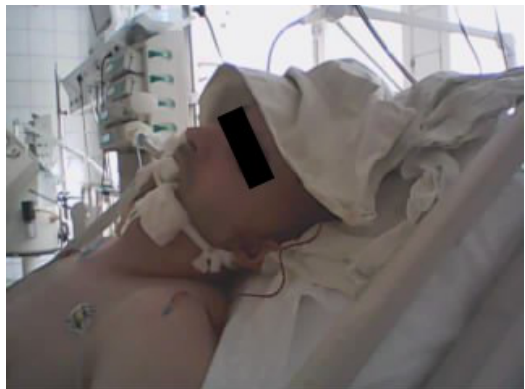
Figure 1. A frame from Video-EEG record. Patient is in